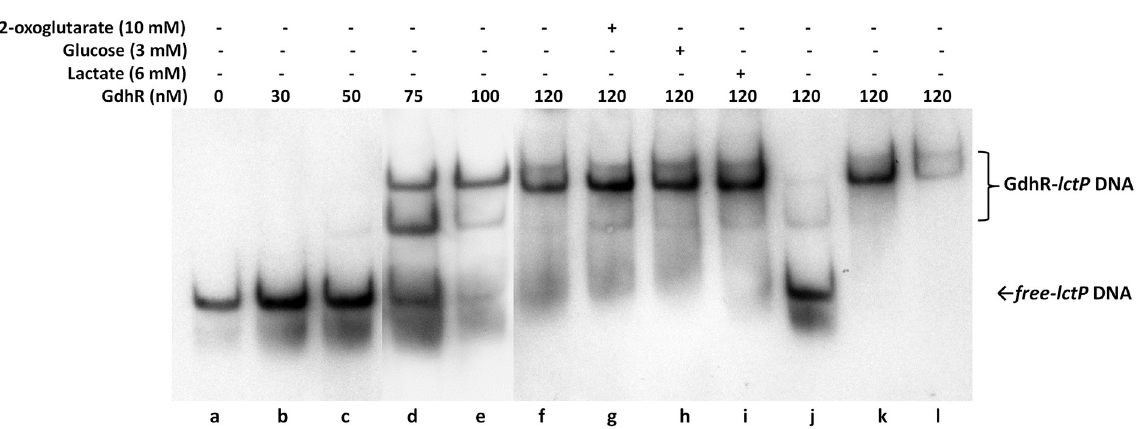
Fig 3. Binding of GdhR to the lctP promoter region. A DIG-labeled DNA fragment spanning nucleotides − 313 to − 23 of the lctP promoter relative to the start codon was incubated with increasing concentrations of purified GdhR. The mobility of free DNA and of the nucleoprotein complexes were determined by EMSA and are indicated at the right of the gel. Competitive EMSAs were prepared by adding a 100-fold excess of unlabeled DNA fragments encoding lctP and recA promoter regions (lane j and k respectively) and 16S ribosomal RNA (lane l).